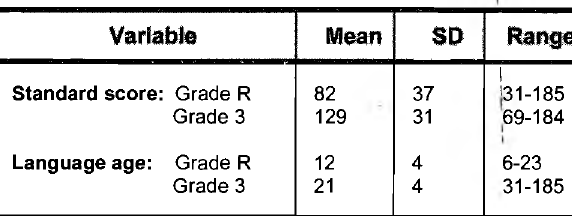
Table 2: Means, standard deviations and ranges of two